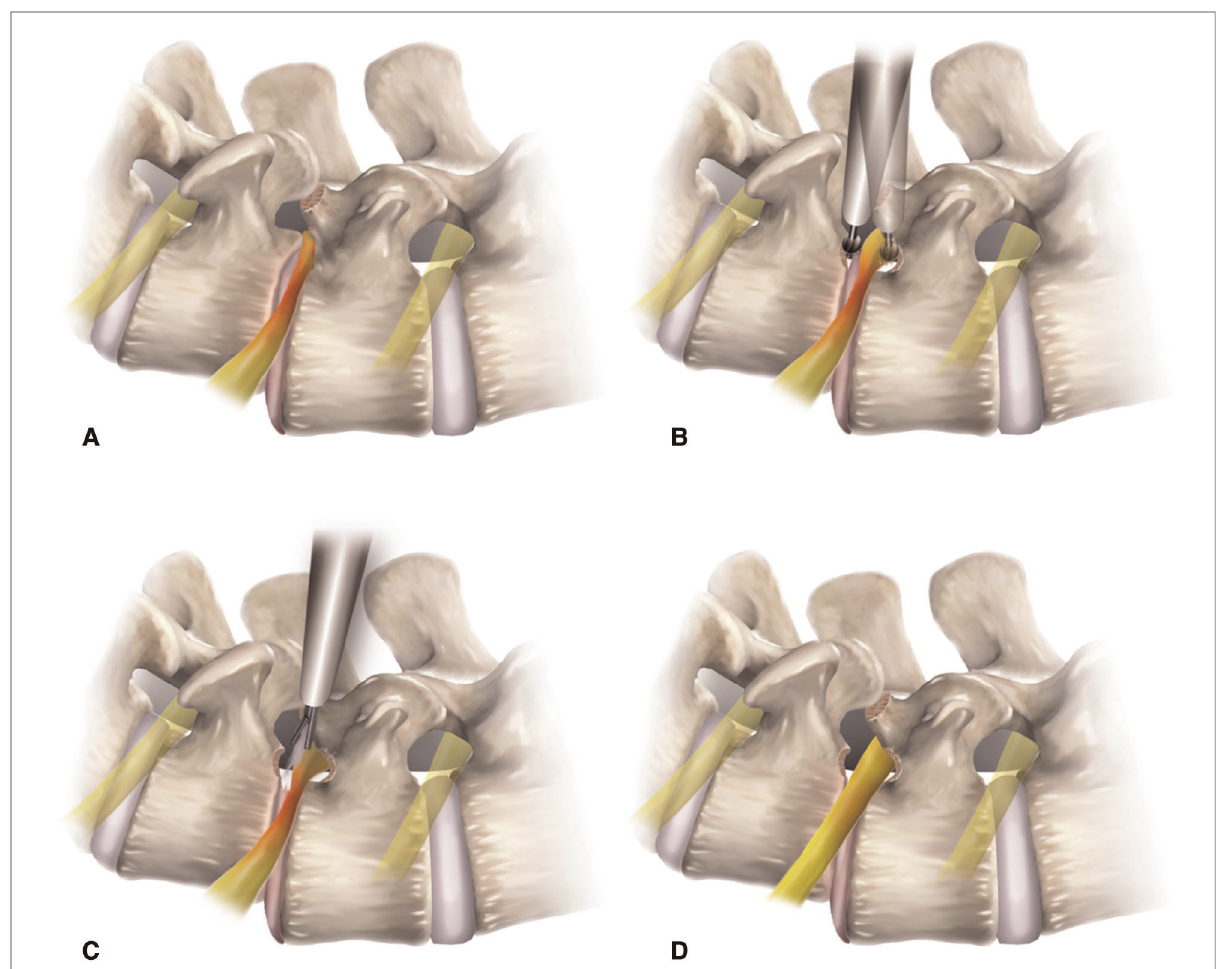
FIGURE 1 Conceptual illustrations depicting the surgical procedure of endoscopic lumbar foraminotomy for spondylolisthesis. (A) Foraminal docking of the working sheath viewing the foraminal surgical fi eld protecting the exiting nerve root (outside-in approach). (B) Foraminal unroo fi ng using endoscopic burrs for resecting the upper pedicle and lower vertebral endplate. (C) Soft tissue decompression with removal of the ligamentum fl avum. (D) Final point of the full-scale foraminal decompression from the axillary side to the lateral exit